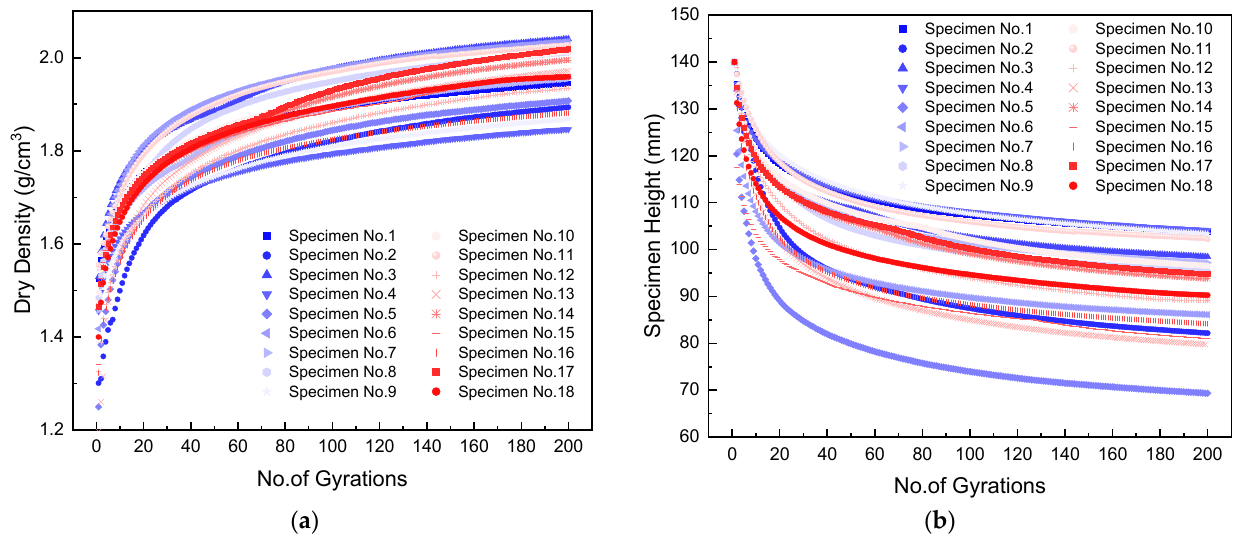
Figure 8. Specimen height and dry density changes versus the number of gyrations for scaled aggregate gradations at different levels of moisture content: ( a ) specimen height and ( b ) dry density.